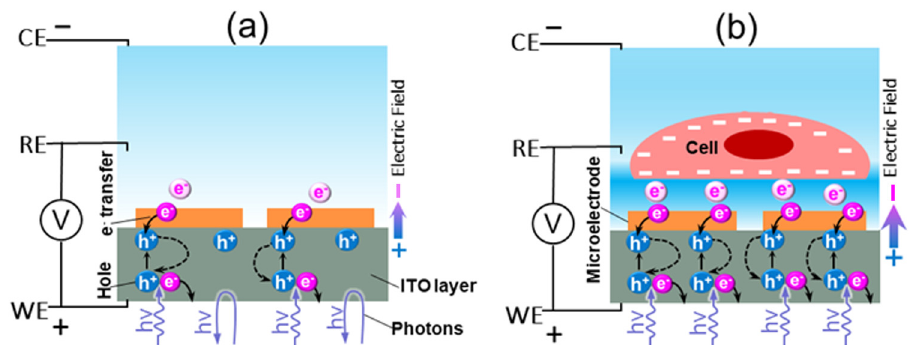
Figure 1. ( a ) Illustration of the method for rapid surface charge mapping. WE, RE, and CE are work- ing, reference, and counter electrodes, respectively. The incident light illuminates the ITO layer from the backside. A cell sits on the surface of a microelectrode array. The local surface charge of the cell induces a change in the photoelectric effect. A CCD camera is used to capture the reflected light. ( b ) Microscopic images and scheme of the microelectrode array.